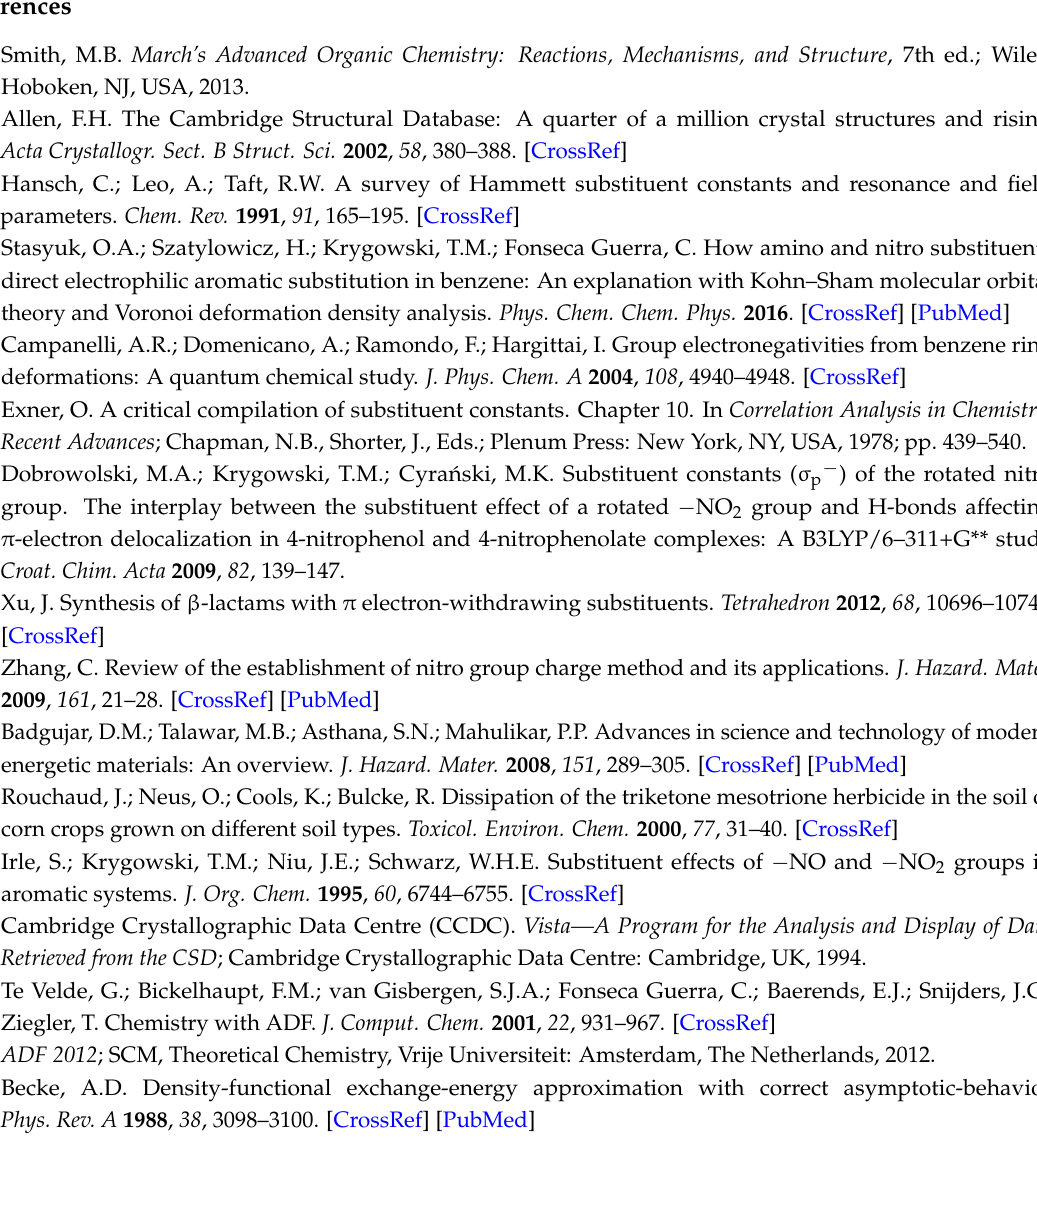
Table S1: Characteristics of substituents in p -nitroaniline. Figure S1: Dependence of cSAR(NO 2 ) on cSAR (NH 2 ) for free PNA. Figure S2: Relation between hydrogen bond energy, E HB , and its length, d HB , for the H-bonded complexes of aniline and p -nitroaniline (NO 2 group is coplanar and perpendicular to the ring plane) with HF or F ´ . Figure S3: Dependences of VDD atomic charge at N and H atoms of amino group on NO 2 rotation, ϕ , for fragment of p -nitroaniline. Figure S4: Dependences of HOMA values on H-bond length for different types of aniline and p -nitroaniline complexes. Figure S5: Correlation between angle of pyramidality of NH 2 group, Φ , and C7-N14 bond length, d CN . Figure S6: Dependence of pyramidality angle, Φ , of NH 2 group on rotation of NO 2 group, ϕ , for H 2 N ¨¨¨ HF